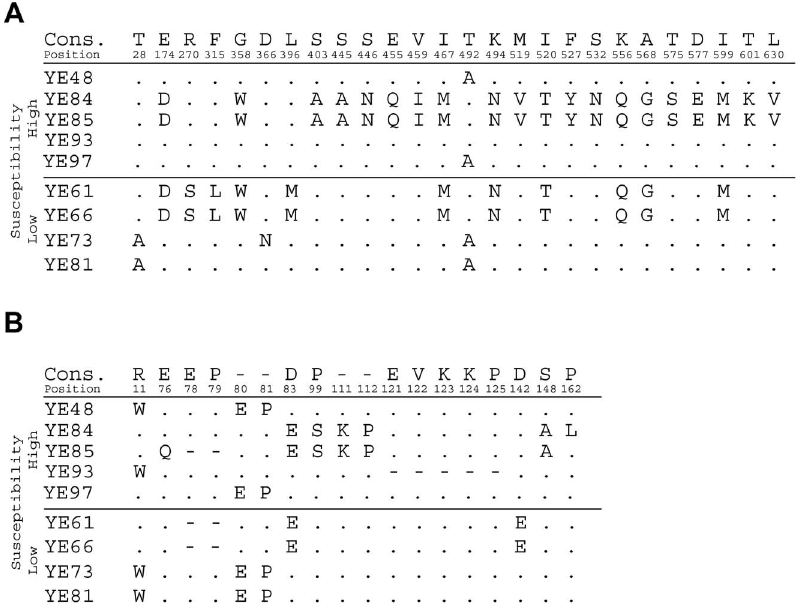
Figure 3. Sequence variability between highly and less susceptible Y.enterocolitica isolates. A) Sequence analysis of YiuR protein from various isolates identified variability in 26 amino acid posistions. B) Sequence analysis of TonB from various isolates identified variability in 18 amino acid positions. A consensus sequence is shown at the top of the figure. The numbers correspond to amino acid position in the YiuR and TonB proteins,